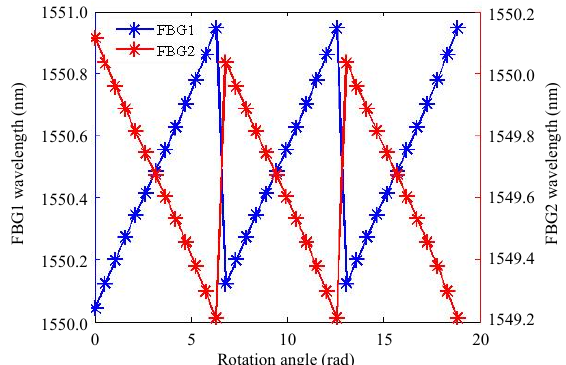
Fig. 8 Central wavelength shifts of FBG1 and FBG2 with the external rotation angle variation.